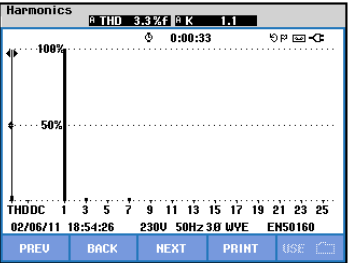
Figure 14. FFT analysis of compensated grid current with inductive load.